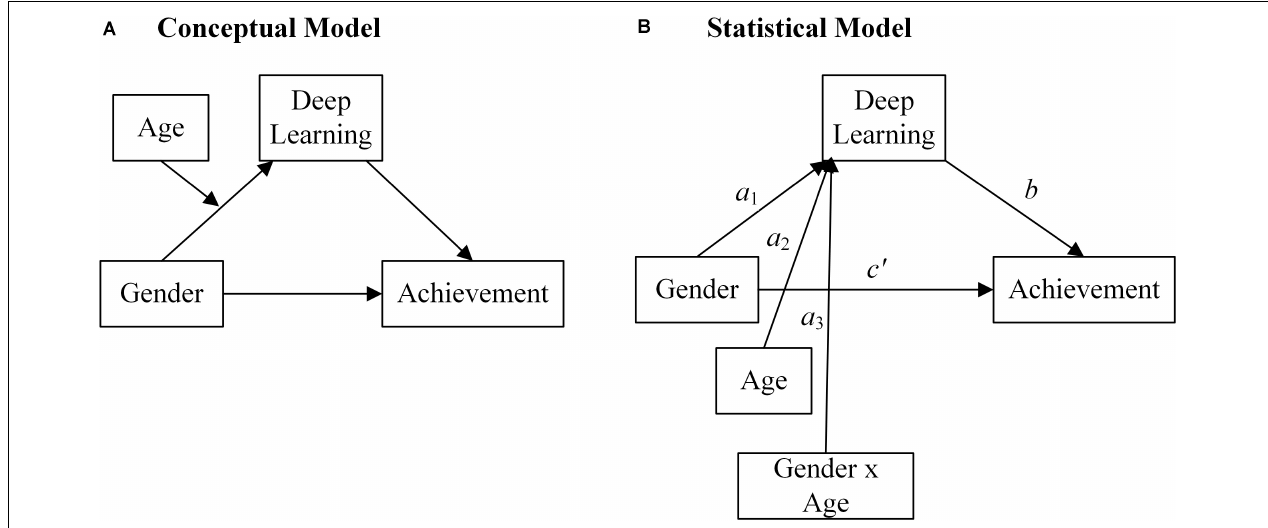
FIGURE 1 | Hypothesized first-stage moderated mediation model including; (A) the conceptual model; and (B) the statistical model specifically tested. a 1 = effect of gender on deep learning; a 2 = effect of age on deep learning; a 3 = effect of the interaction between age and gender on deep learning; b = effect of deep learning on achievement; c (cid:48) = direct effect of gender on achievement (with gender, age, and deep learning